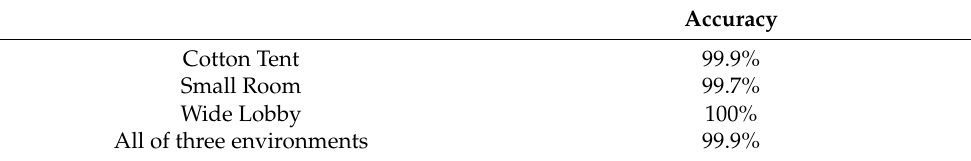
Table 4. Activity monitoring accuracies in three indoor environments and for the whole dataset.